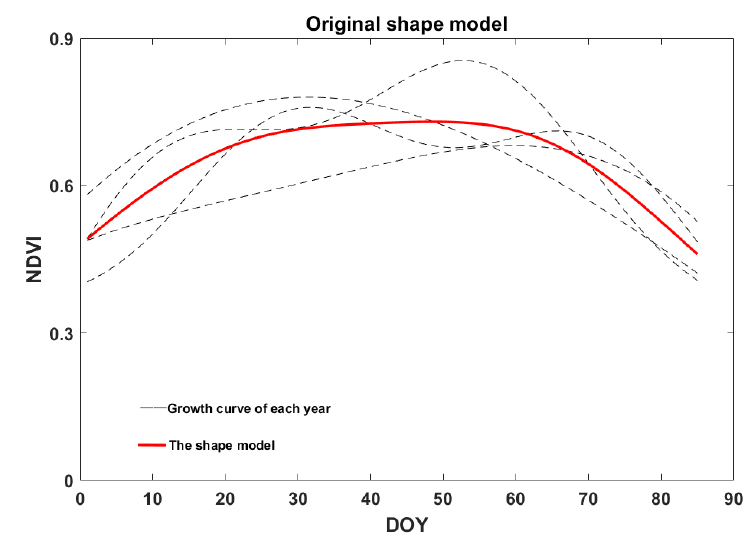
Figure 4. Shape model of early rice based on calendar day.